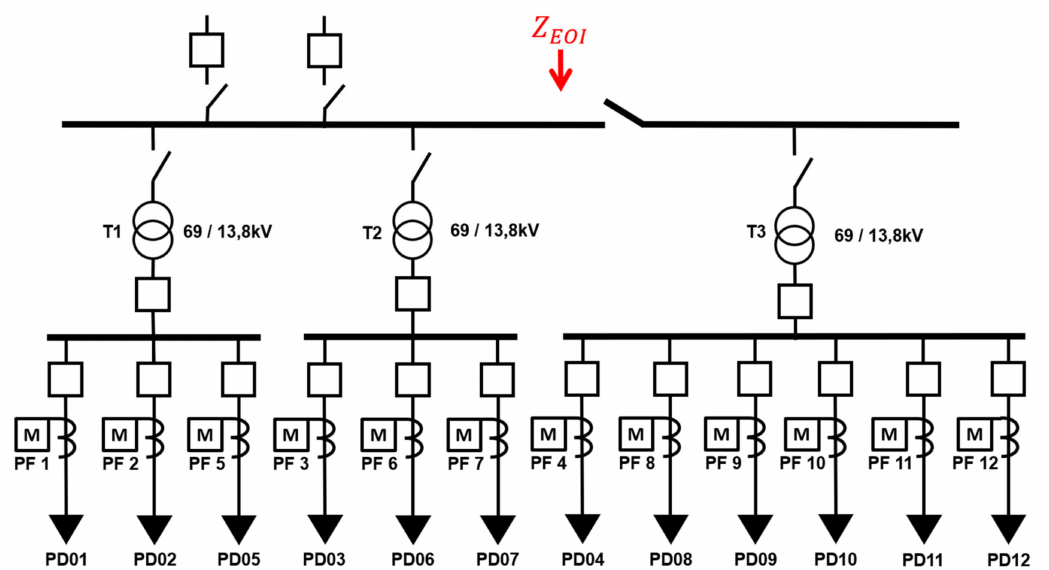
Figure 13. The Pedreira Distribution Substation main configuration.